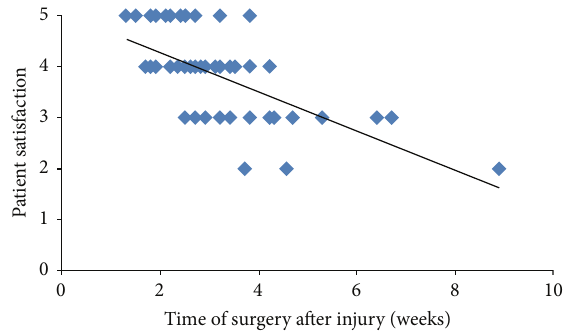
Figure 1: Relationship between timing of surgery after injury and patient